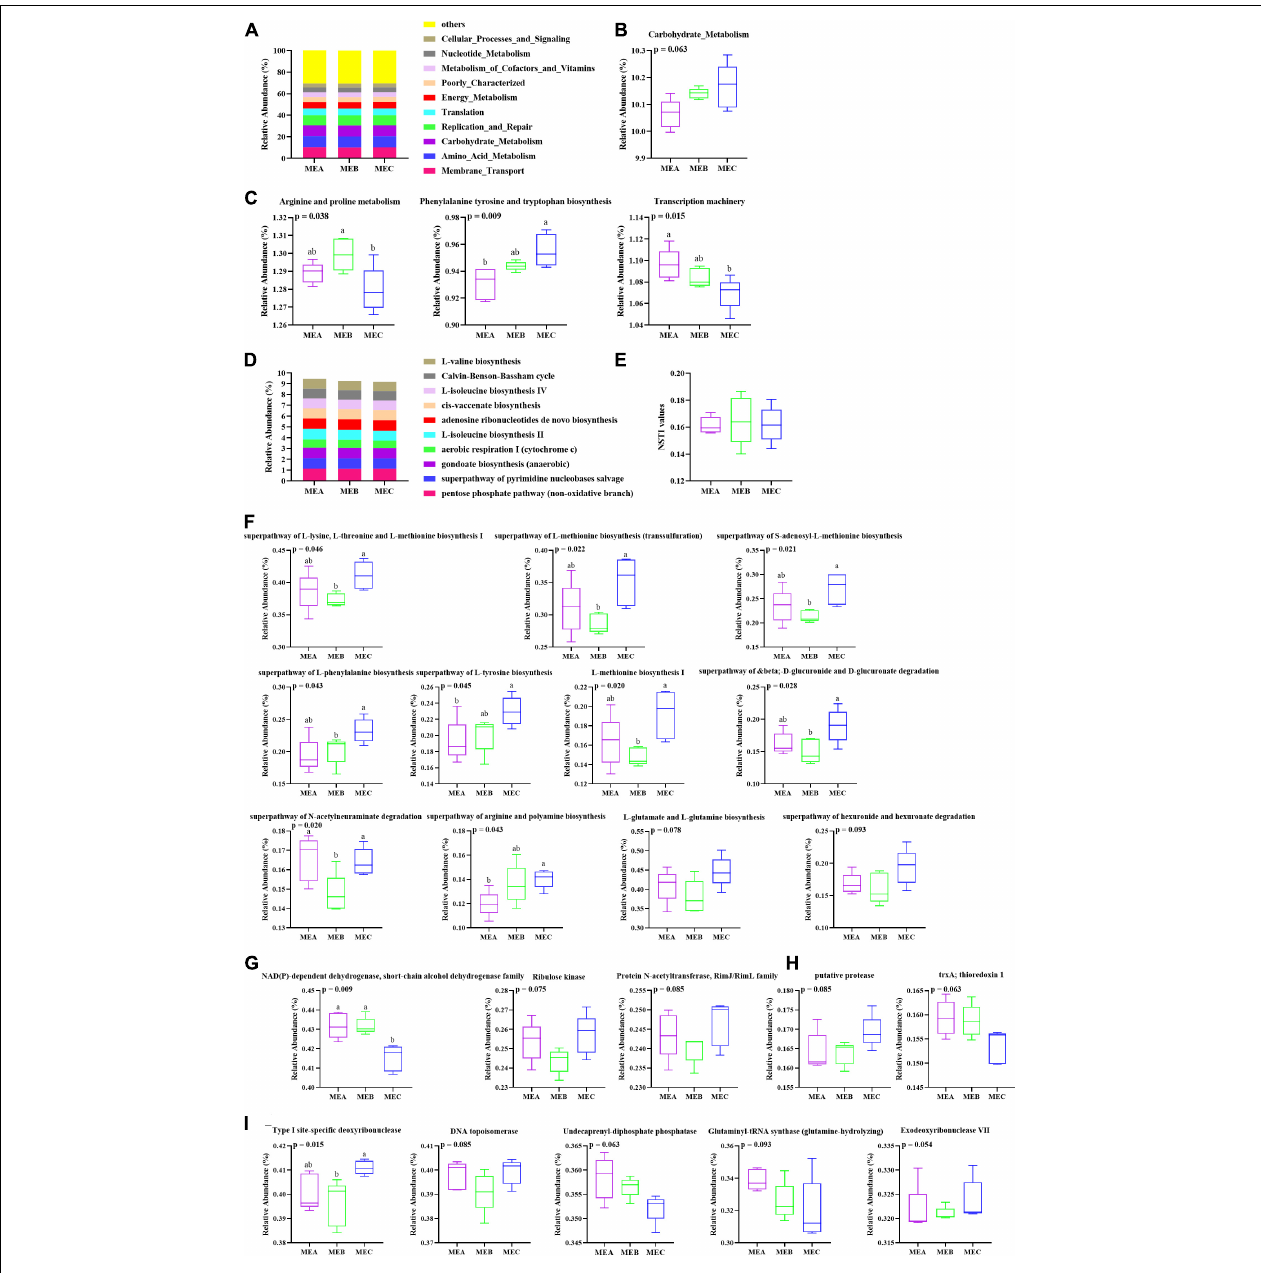
FIGURE 4 | Functional prediction of low, medium, and high dietary energy of rumen microbial community and related pathways. (A) Relative abundance of the dominant pathways annotated to KEGG level 2. (B) Relative abundance of carbohydrate metabolism. (C) Relative abundance of representative pathways at KEGG level 3. (D) The top 10 relative abundance of KEGG pathways by PICRUSt2. (E) The NSTI values. (F) The differential metabolic pathways by PICRUSt2. (G) The variation in top 35 relative abundances of COG analysis. (H) The variation in top 35 relative abundances of KO analysis. (I) The variation in top 35 relative abundances of EC analysis. Values with different superscripts (a,b) differ significantly at p <